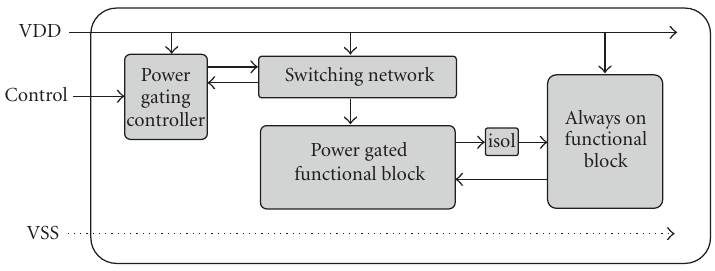
Figure 3: Block diagram of a SoC with power gating, adapted [1].